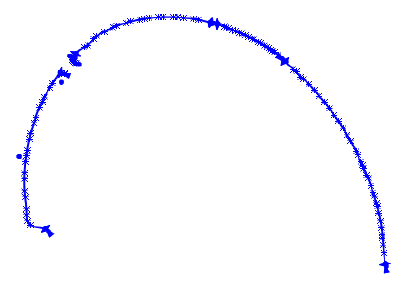
Figure 5. Cross-section curve.